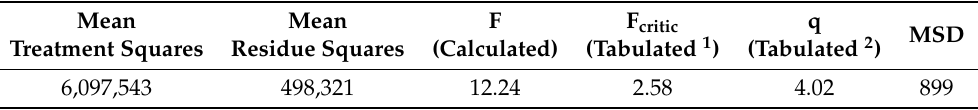
Table 12. ANOVA and Tukey’s test parameters for longitudinal wave velocity. Mean